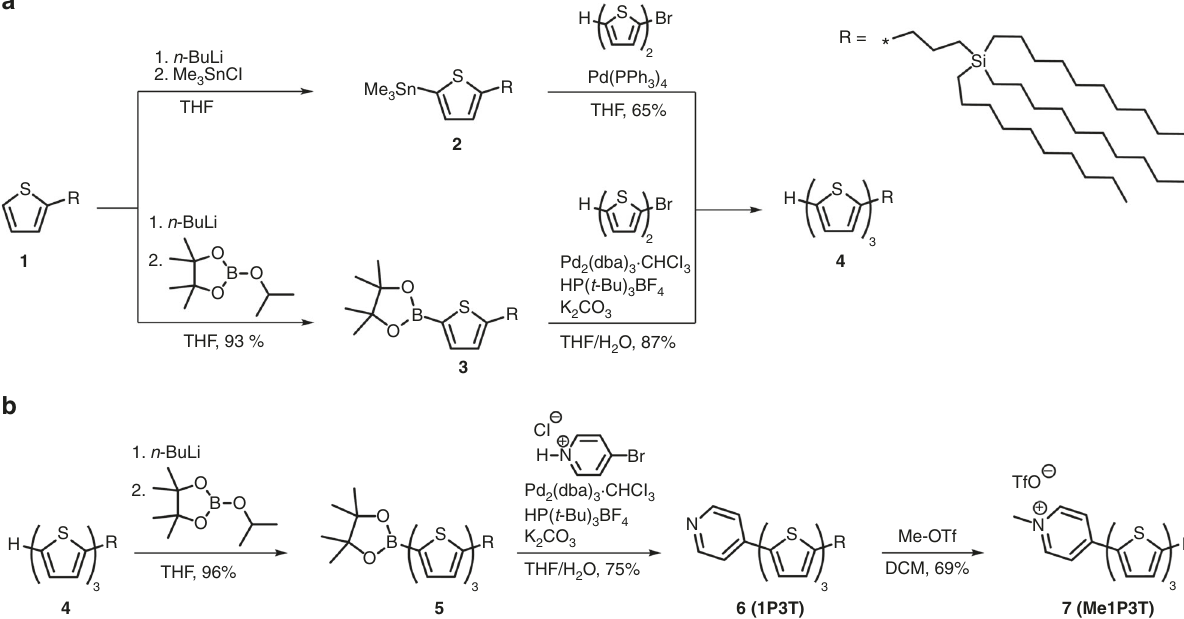
Fig. 1 Synthesis of the oligothiophene analogues. a Stille- VS Suzuki-Miyaura-type cross-coupling reactions to monosubstituted terthiophene 4 . b Synthesis of pyridine-functionalized terthiophene 6 (1P3T) via Suzuki-Miyaura-type cross-coupling and subsequent N -methylation reaction of latter to achieve the permanently positive charged derivative 7